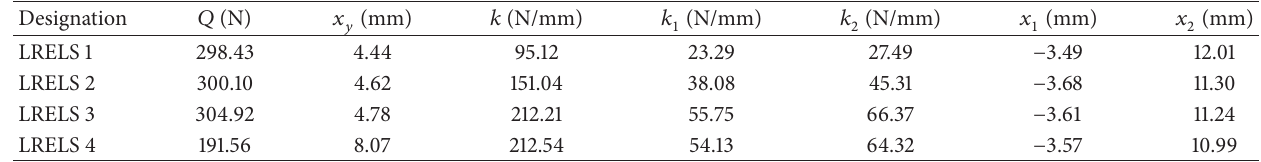
Table 4: Parameters of model isolators in the vertical